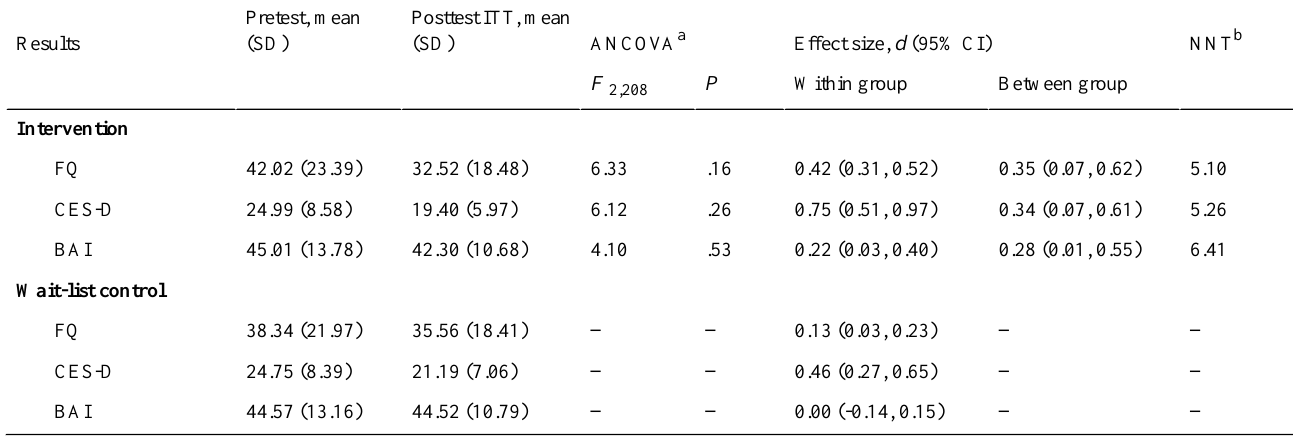
Table 3. Main results, imputed intention-to-treat sample